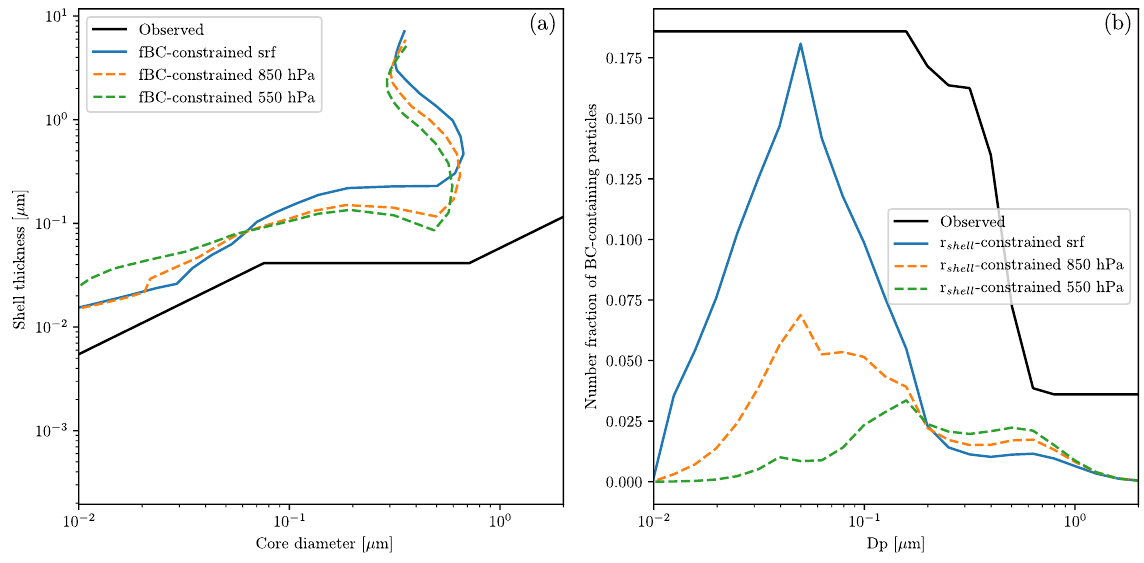
Figure 6. The simulated pan-Arctic mean shell thickness as a function of BC core diameter when the number fraction of BC is constrained by observations (a) , and the simulated number fraction of BC when shell thickness as a function of core diameter is constrained by observa- tions (b) .